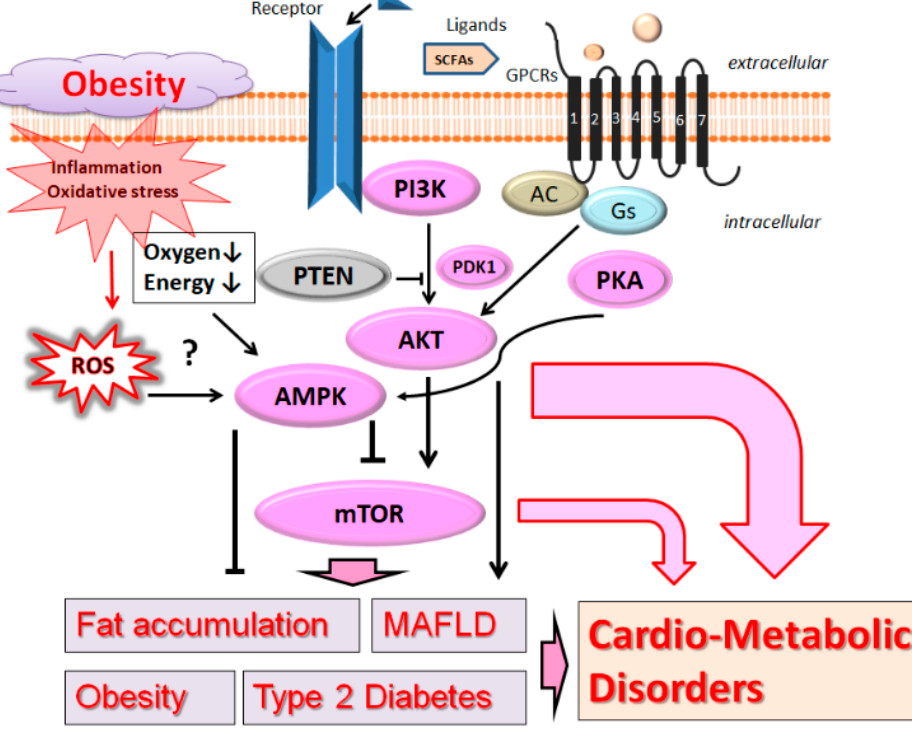
Figure 1. A hypothetical schematic image and overview of the pathogenesis of cardio-metabolic disorders. The PI3K/AKT/AMPK/mTOR signaling pathway might intricately contribute to the pathogenesis of obesity, type 2 diabetes mellitus, metabolic-associated fatty liver disease (MAFLD), which are all related to the pathogenesis of cardio-metabolic disorders. Arrowhead indicates stimulation, whereas hammerhead shows inhibition. Note that several important activities such as inflammatory-related reactions have been omitted for clarity. Abbreviation: MAFLD, metabolic- associated fatty liver disease; AMPK, adenosine monophosphate-activated protein kinase; mTOR, mammalian/mechanistic target of rapamycin; PI3K, phosphoinositide-3 kinase; PKA, protein kinase A; PTEN, phosphatase and tensin homologue deleted on chromosome 10; ROS, reactive oxygen species. (Numbers in black boxes: G protein-coupled receptors (GPCRs) are commonly seven-(pass)-transmembrane domain receptors.)